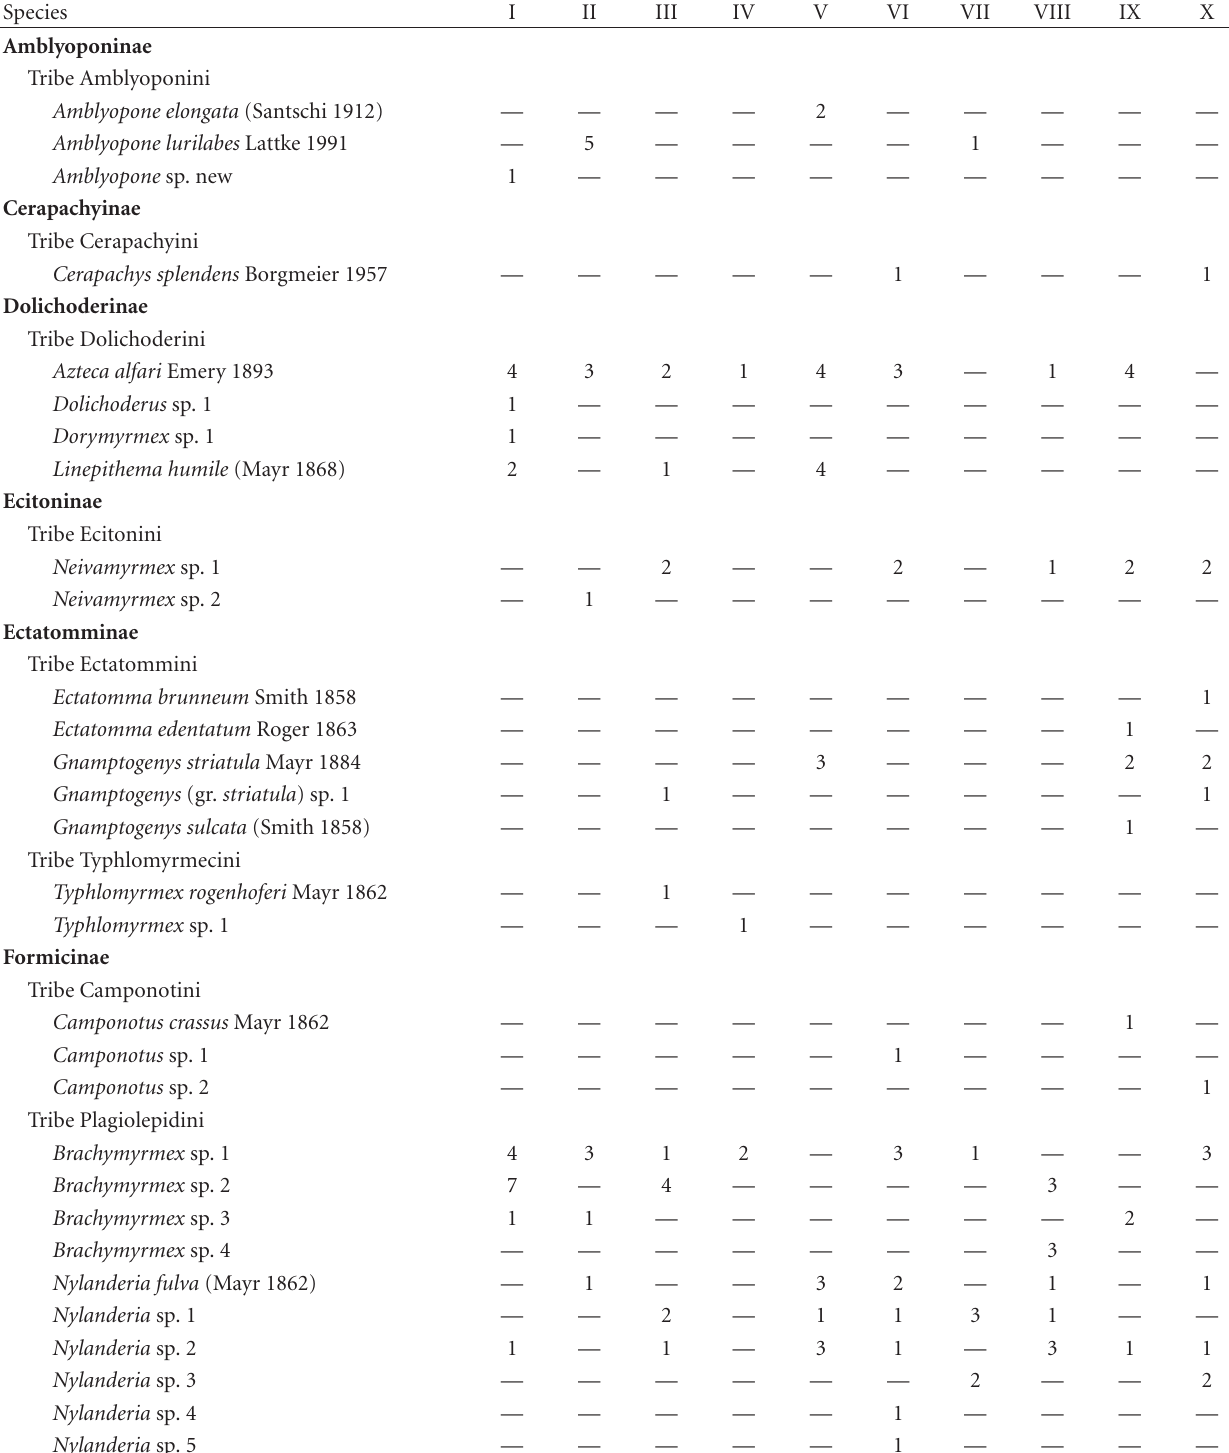
Table 2: Records of occurrences of the 170 species collected at 10 sampling sites in Serra da Bodoquena National Park, Mato Grosso do Sul, Brazil. Species